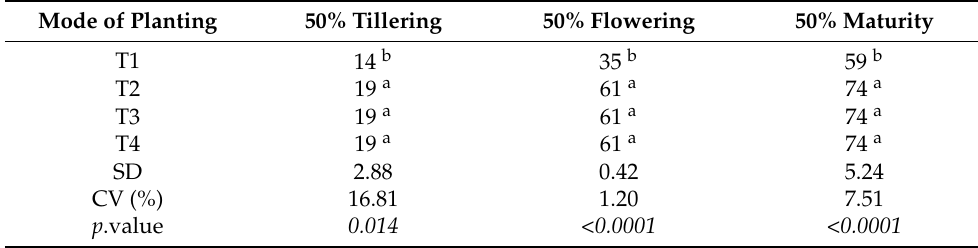
Table 2. Phenological stages according to the mode of